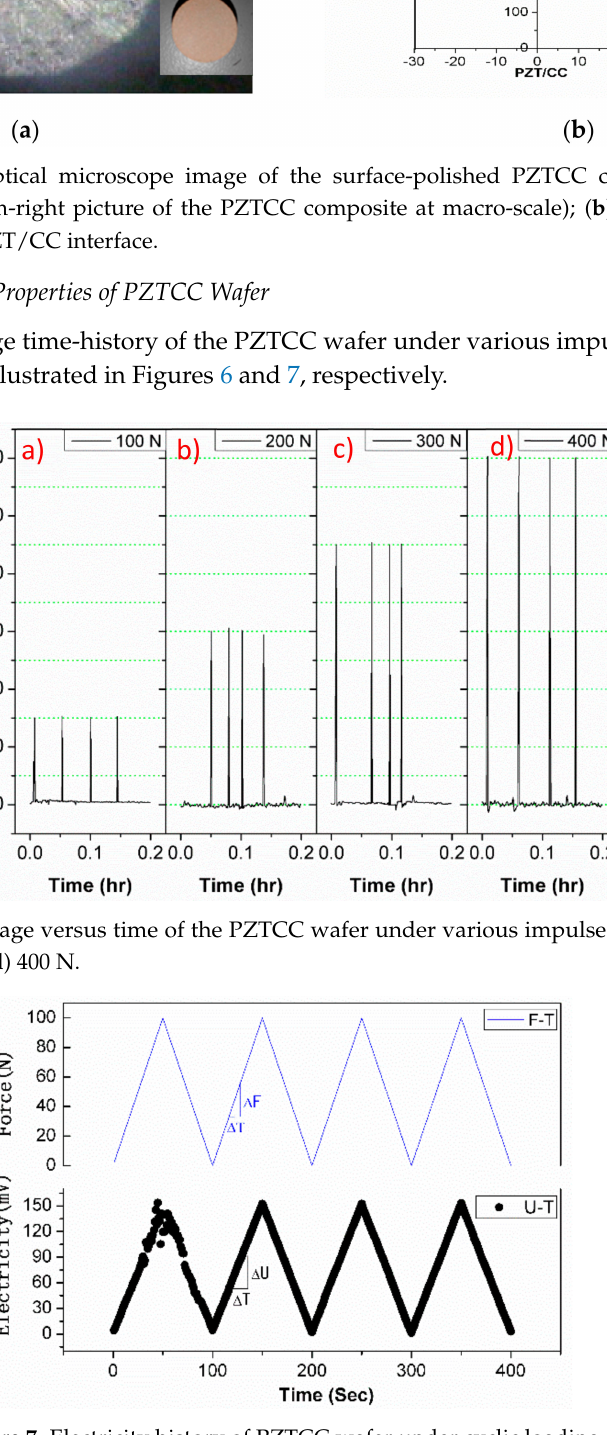
Figure 7. Electricity history of PZTCC wafer under cyclic